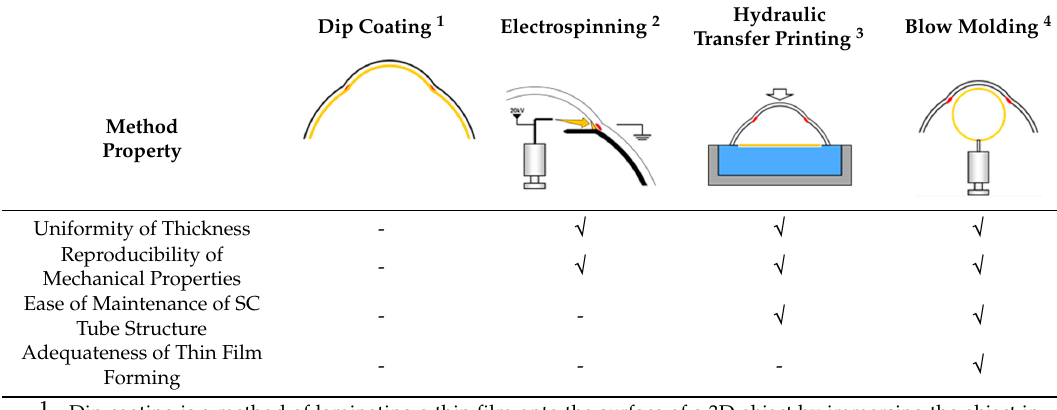
Table 1. Benchmark of fabrication methods to fabricate the artificial trabecular meshwork for a glaucoma model.